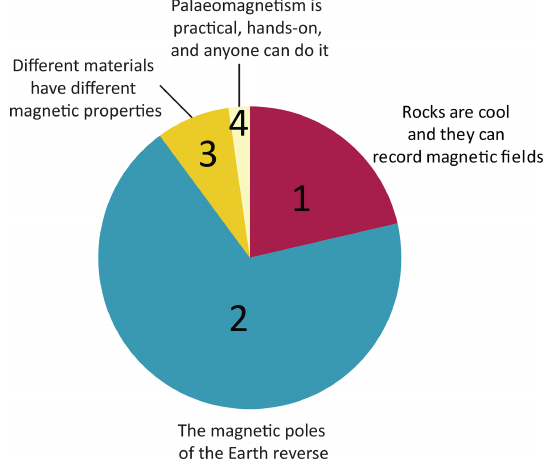
Figure 8. Learning outcomes (LOs) mentioned by participants as the things they had learnt. LO 1 – rocks are cool, and they can record magnetic fields. LO 2 – the magnetic poles of the Earth re- verse. LO 3 – different materials have different magnetic